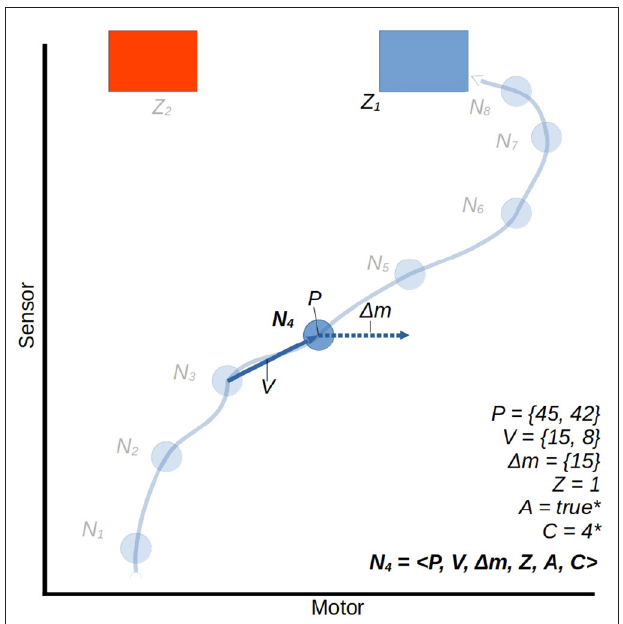
FIGURE 7 | A visualization of the mapping function using the similarity metric described in Equation (5). This illustrates the moment in which node N a is being created. The position in sm-space P a and displacement from the previous node V a will be compared to those of every nearby node. We isolate two of the three nearest nodes, N b and N c , to compare. N c is closest in space to N a , but the velocity of the trajectory associated with N c is very different from that of the current trajectory. N b is slightly further away, but the velocity of its associated trajectory is much more similar, so N b is selected as the parent node of N a . 1 m a is taken as the average between 1 m b and the hypothetical vector which would put N a ’s successor at the same motor state as N b ’s successor. This is indicated by the pale arrows behind the 1 m a